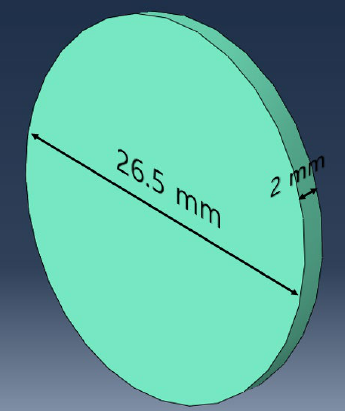
Figure 7. Dimension of defect in FE simulation . Table 2. Material properties of defect in FE simulation .